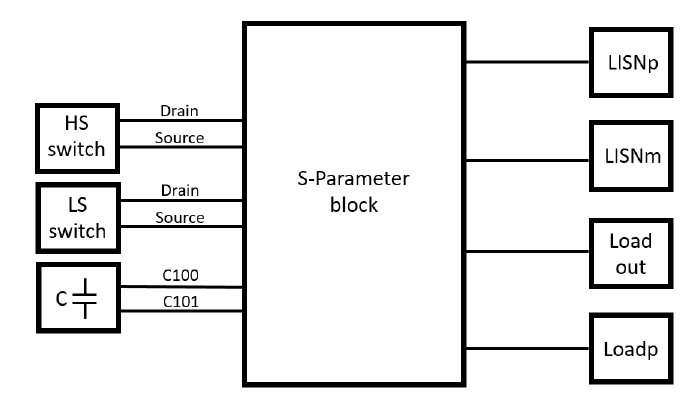
Figure 10. Extracted S-Parameter model from 3D FEM simulations.